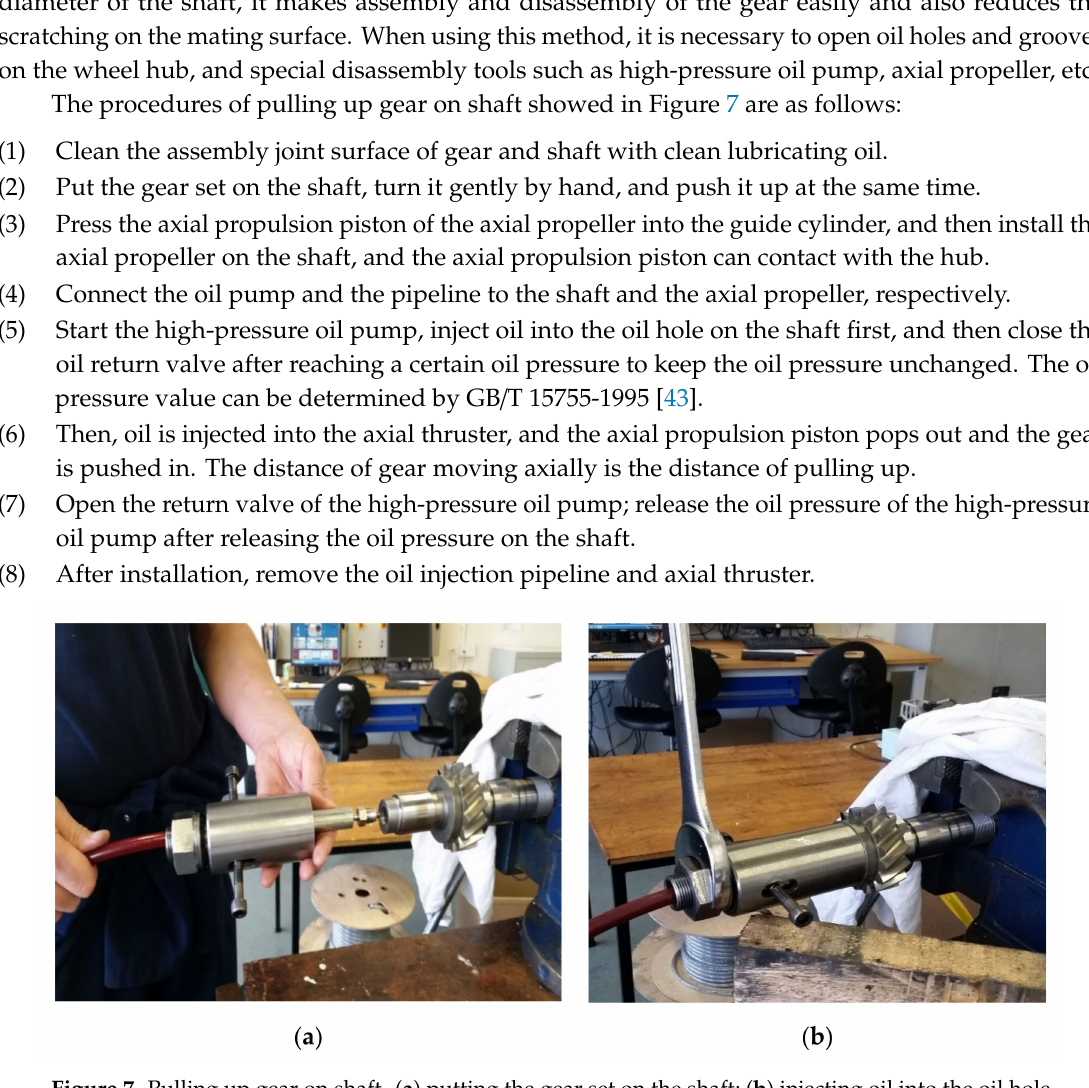
Figure 7. Pulling up gear on shaft. ( a ) putting the gear set on the shaft; ( b ) injecting oil into the oil hole on the shaft and gear is pushed